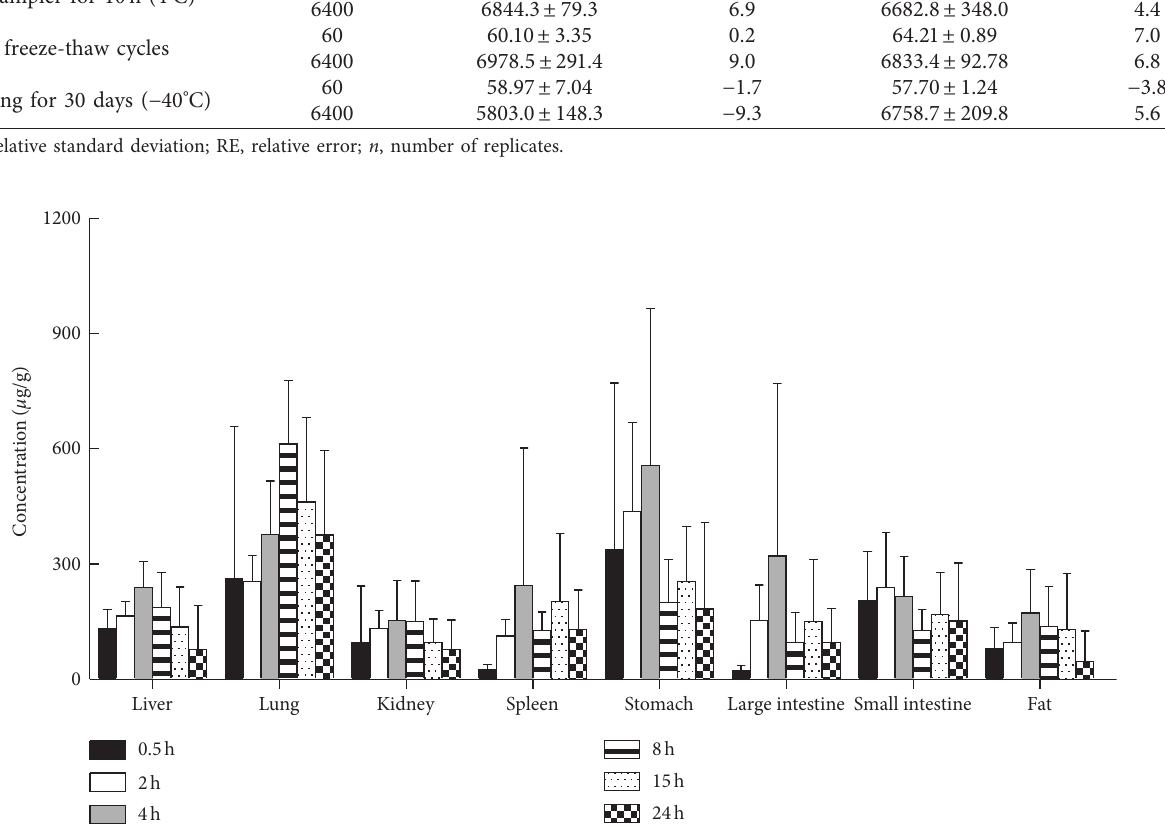
Figure 5: Concentrations of crizotinib in the eight tissues at 0.5h, 2h, 4h, 8h, 15h, and 24h after an intragastric administration of crizotinib (500 mg/kg) in healthy mice. Data are means ± SD.